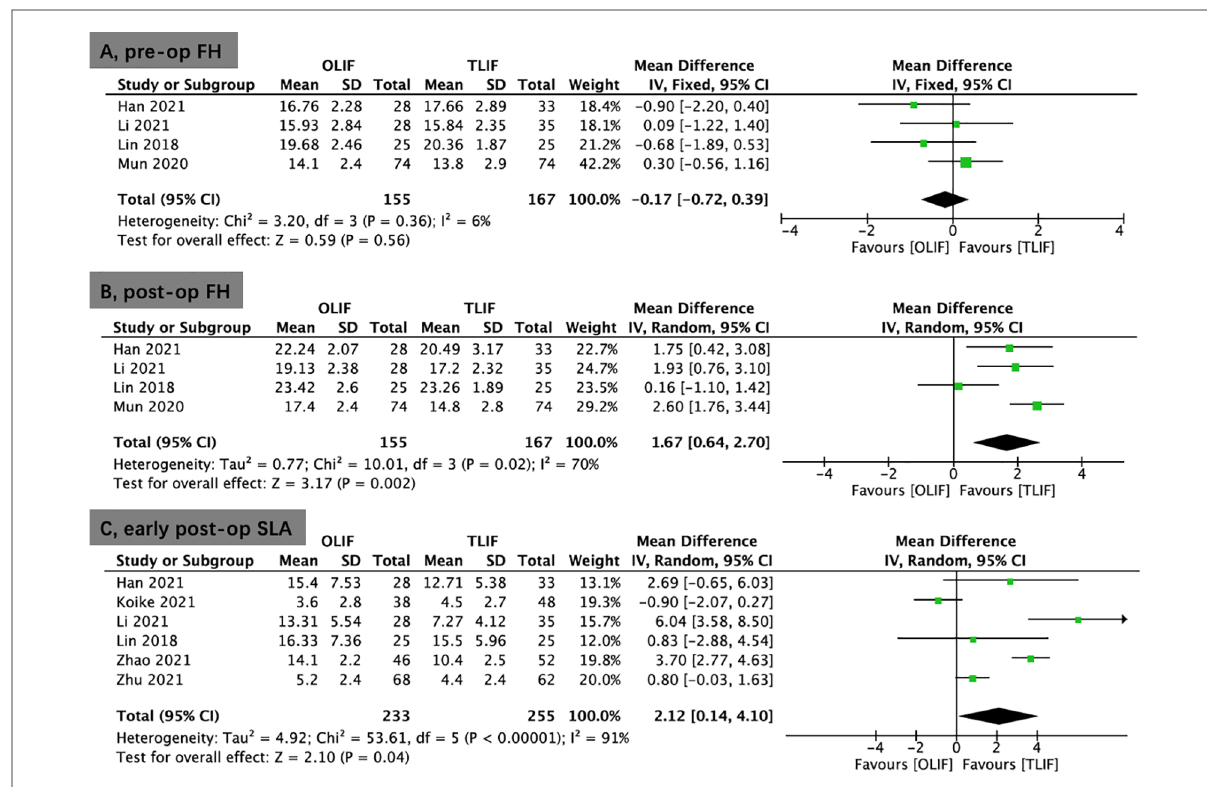
FIGURE 6 Forest plots for comparison of FH at preoperative ( A ), and postoperative ( B ) between OLIF and TLIF. ( C ), Forest plots for comparison of SLA at early postoperative (<1 week) between OLIF and TLIF. FH, foraminal height; SLA, segmental lordotic angle; OLIF, oblique lumbar interbody fusion; TLIF, transforaminal lumbar interbody